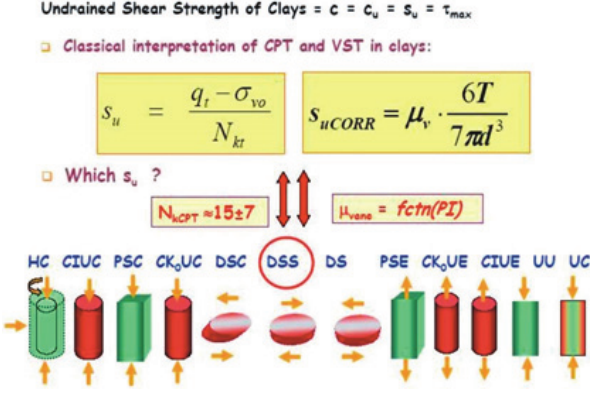
Fig. 1. Determination of shear strength s u from laboratory analysis in the direct shear test DSS, the triaxial shear test TXT or cone penetration test CPT, vane testing VT [3]